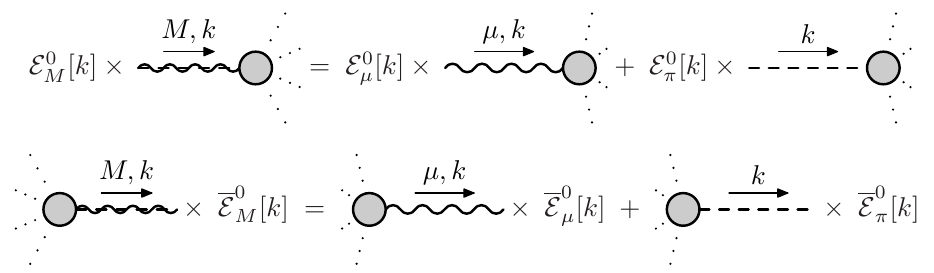
Figure 1: Feynman rules for incoming (top) and outgoing (bottom) external longitudinal